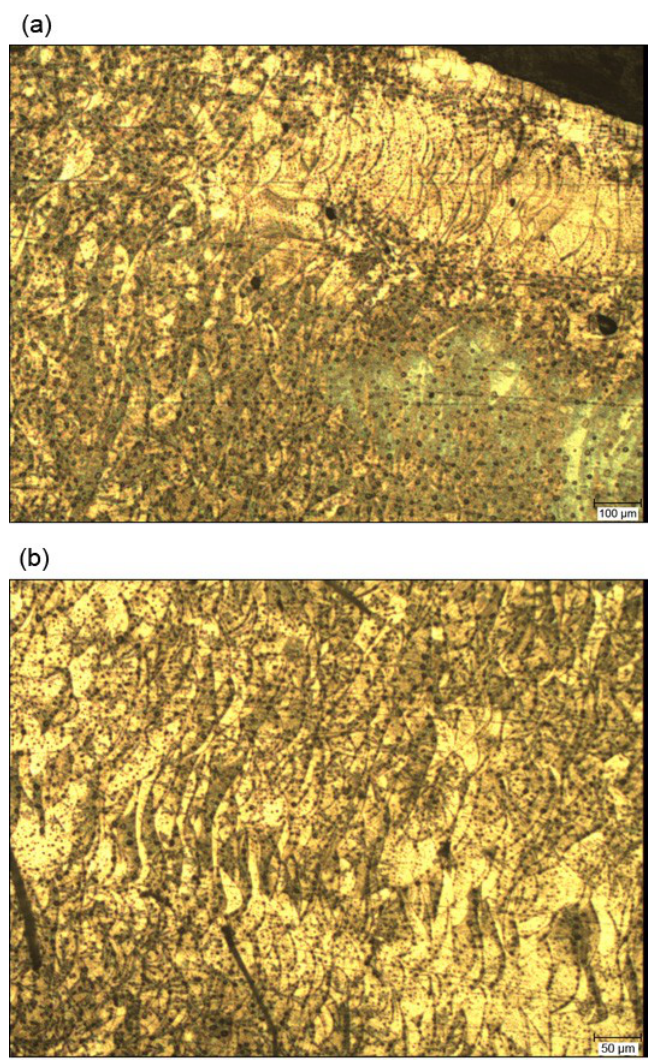
Figure 10. The microstructure of the cross-section of the DMLS sample: ( a ) magnification of 60×; ( b ) magnification of